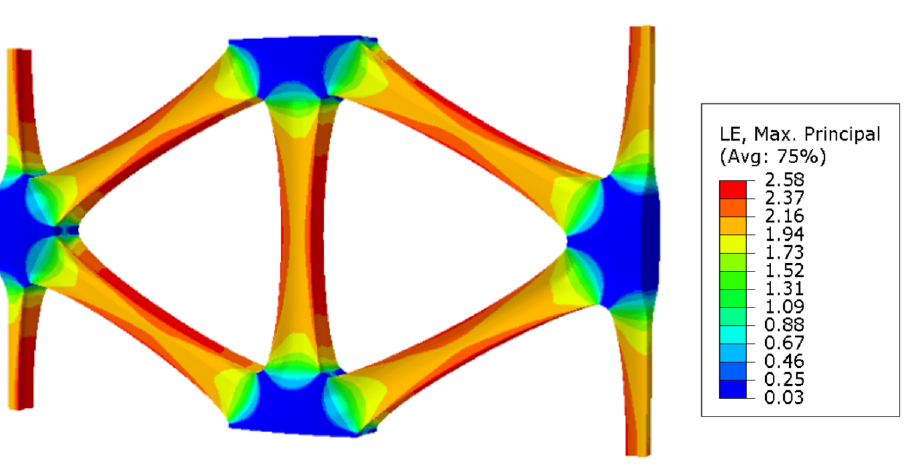
Figure 19. Simulation result of a triaxial geogrid with a pre-punched diameter of 2.6